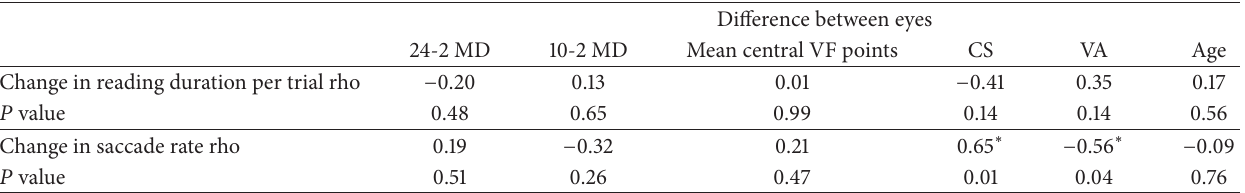
Statistically significant associations are marked with an asterisk.